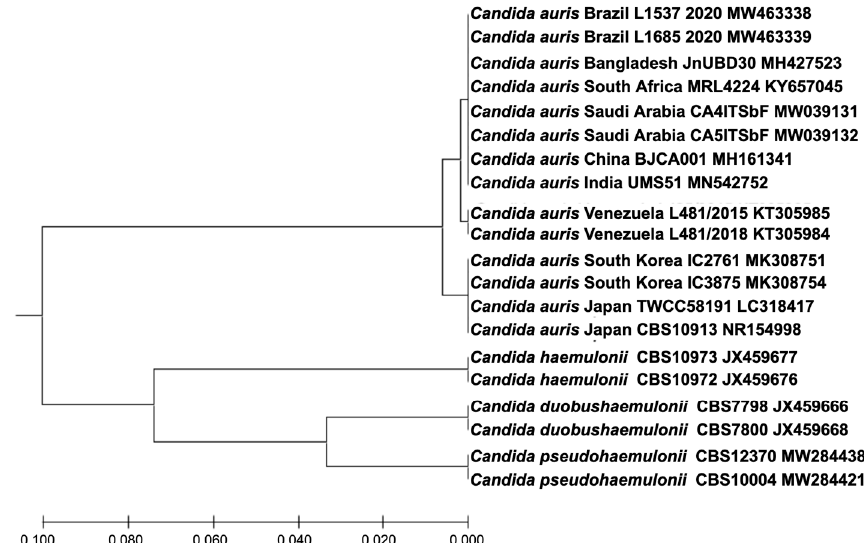
Figure 1. UPGMA phylogenetic tree generated with MEGA X software [8]. There were 20 nucleotide sequences and 299 nucleotide positions in the final dataset. The evolutionary distances were computed using the Maximum Composite Likelihood method and are in the units of number of base substitutions per site.